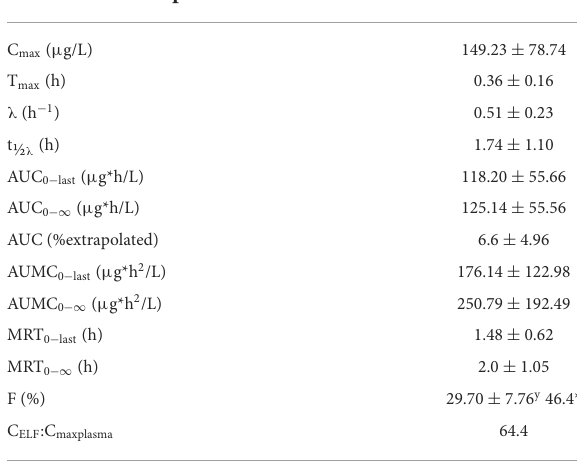
TABLE 4 Pharmacokinetic parameters of lidocaine following a single nebulized 1.0 mg/kg dose in 6 healthy adult